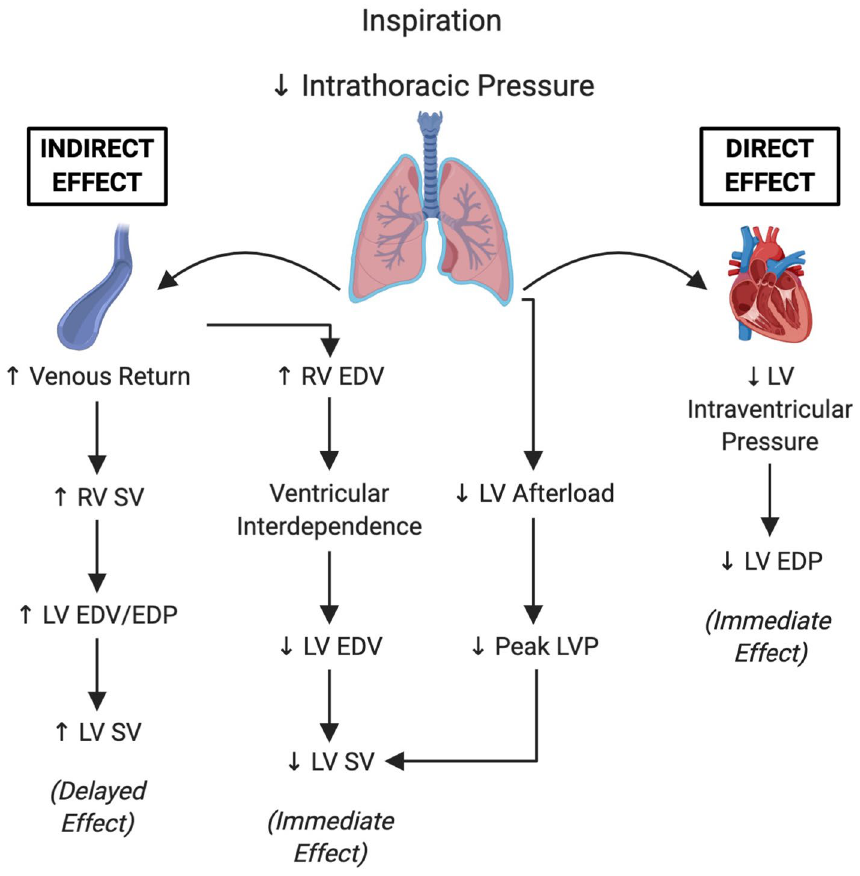
Figure 7. Summary figure. Schematic overview highlighting how inspiratory intrathoracic pressures produce immediate and delayed effects on ventricular pressures and volumes. RV Right ventricle, SV Stroke volume, EDV End diastolic volume, EDP End diastolic pressure, LVP Left ventricle pressure. Partially adapted from Amoore and Santamore 3